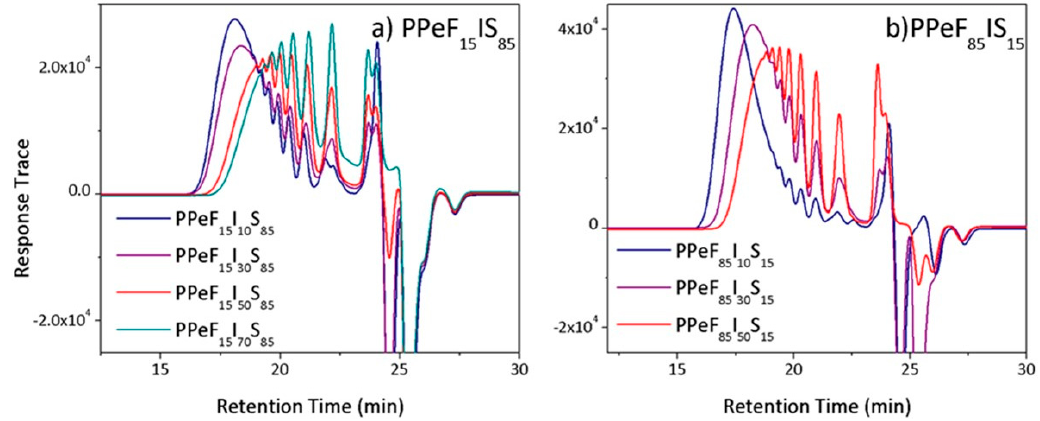
Figure 3. Gel permeation chromatography (GPC) chromatographs of ( a ) PPeF 15 IS 85 and ( b ) PPeF 85 IS 15 .